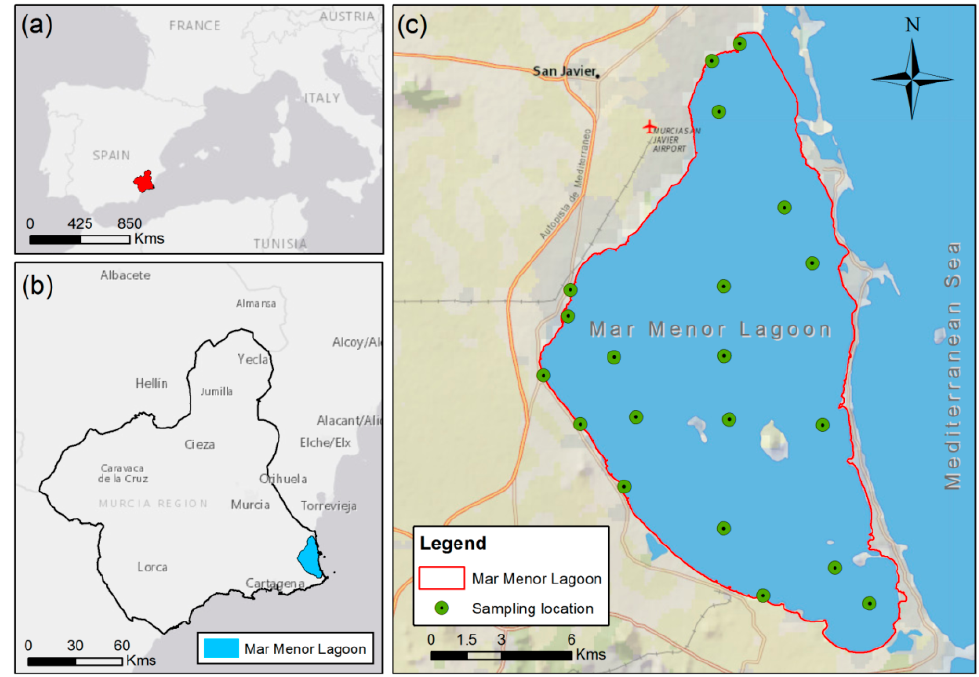
Figure 1. Study site location: ( a ) Location of the Region of Murcia in Spain; ( b ) Location of the Mar Menor lagoon in the Region of Murcia; ( c ) Mar Menor Lagoon and the network of sampling points.